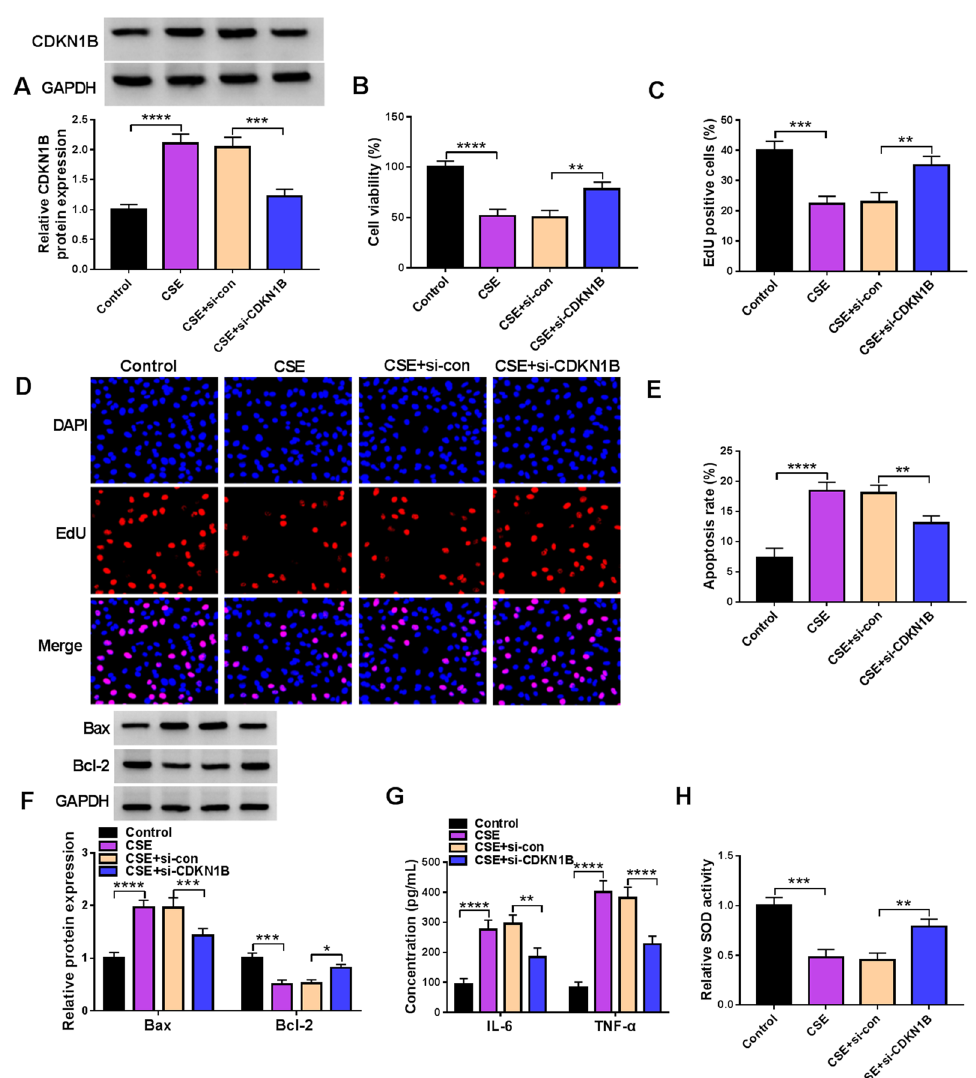
Fig. 6 CDKN1B silencing reverses CSE-induced 16HBEC injury. A – H 16HBECs were transfected with si-CDKN1B or si-NC, followed by treatment with 2% CSE for 24 h. ( A ) Transfection efficiency. B – D 16HBEC proliferation analysis. E 16HBEC apoptosis detection. F Levels of Bax and Bcl-2 in 16HBECs. G Levels of IL-6 and TNF-α in 16HBECs. H Measurement of SOD content in 16HBECs using a commercial kit. * P < 0.05, ** P < 0.01, *** P < 0.001, **** P <